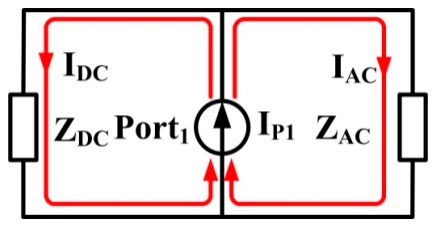
8 of 18 Figure 10. Equivalent circuit at 26 MHz. Table 2. Elements responsible for resonances. Frequency Responsible Elements 6 MHz resonance